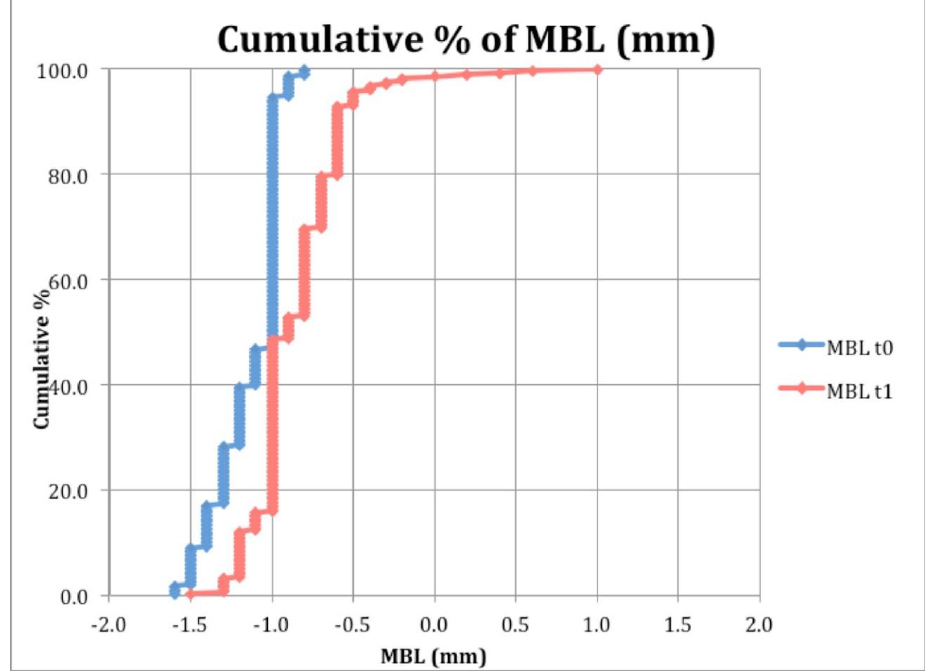
Figure 3. Cumulative percentage of MBL at baseline (t 0 ) and after 2 years from loading.